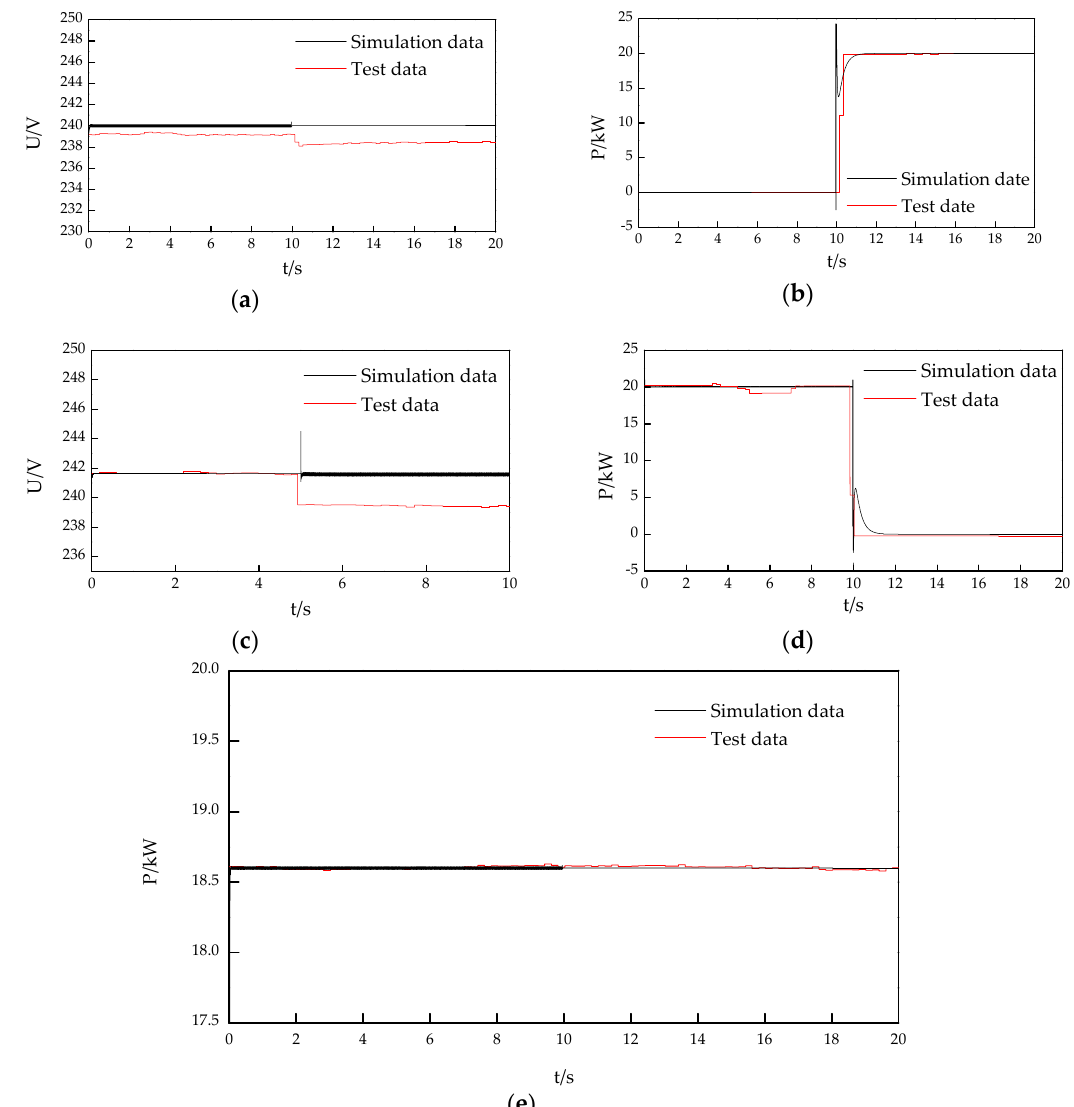
Figure 11. ( a ) Comparison of the voltage at PCC; ( b ) Comparison of the active power at PCC; ( c ) Comparison of the frequency at PCC; ( d ) Comparison of the active power of energy storage unit; ( e ) Comparison of the active power of PV unit.